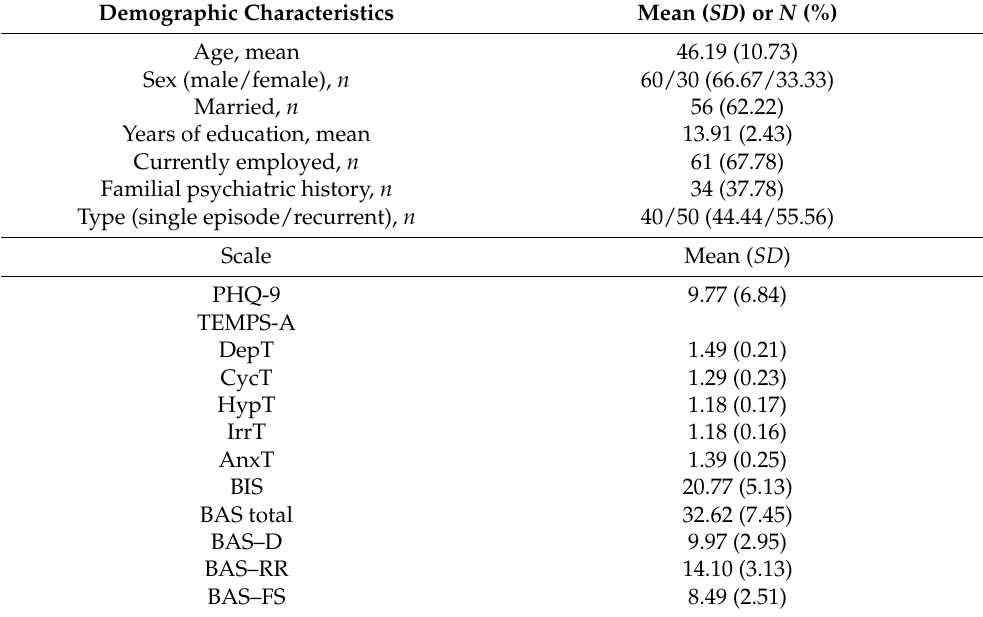
Table 1. Basic findings ( N =